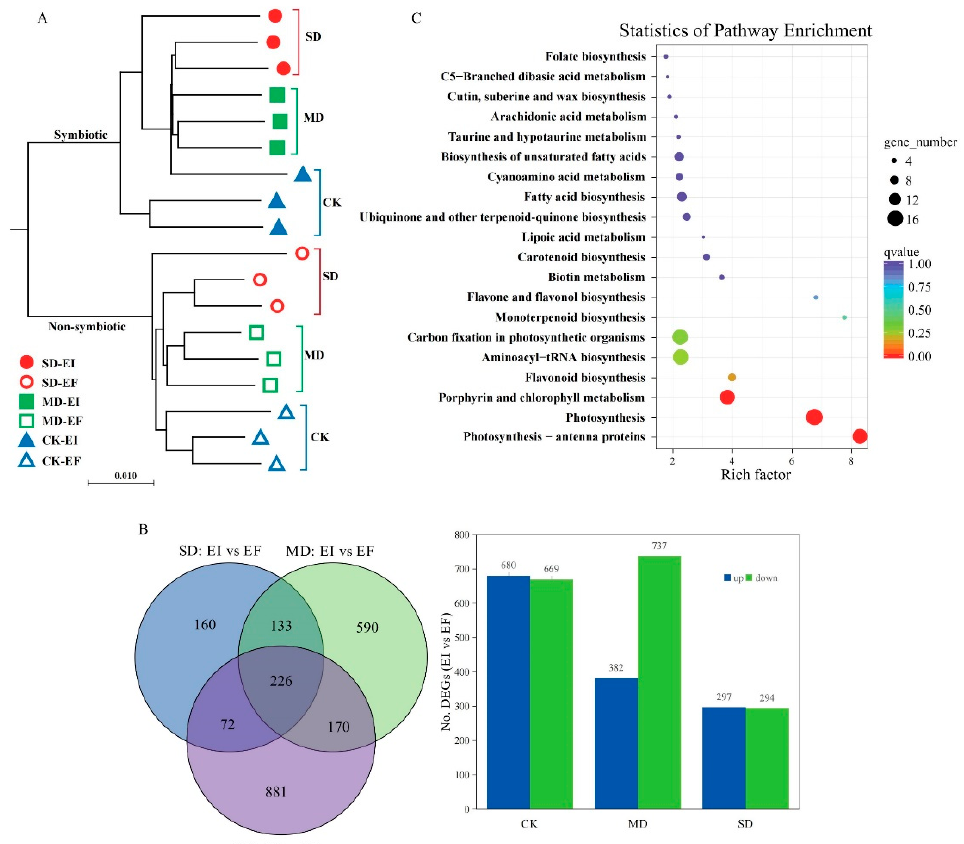
Figure 1. The unigenes and differently expressed genes (DEGs) based on the leaf transcriptome data of Achnatherum inebrians plants in response to the presence of the Epichloë fungal endophyte under non-drought (CK), moderate (MD), and severe (SD) drought treatments. Note: ( A ): The sample similarity analysis of all unigenes detected in the leaves of Epichloë symbiotic (EI) and non-symbiotic (EF) plants under CK, MD, and SD moisture treatments. ( B ): The number of all and up/down-regulated DEGs in EI plants versus EF plants under CK, MD, and SD moisture treatments. ( C ): Kyoto Encyclopedia of genes and genomes (KEGG) pathway enrichment of DEGs in response to the Epichloë endophyte under CK treatment; the dot color represents the enrichment q-value of the related pathway, and the dot scale indicates the number of DEGs in the pathway.